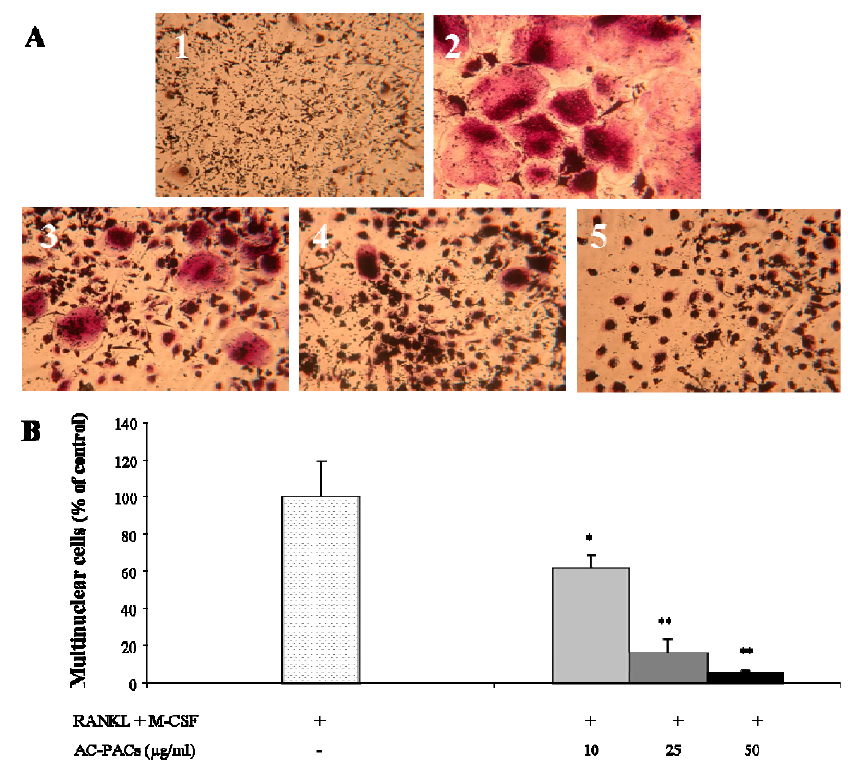
Figure 3. Inhibitory effect of AC-PACs on the differentiation of human